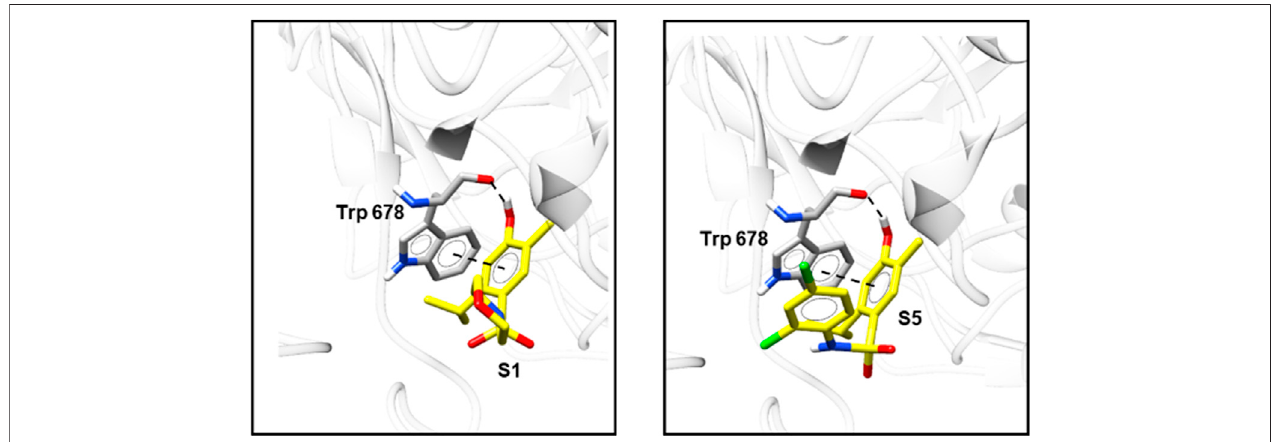
FIGURE 9 | Top-scoring docking poses for S1 and S5 in the binding site of NO synthase (PDB ID 6NGJ).